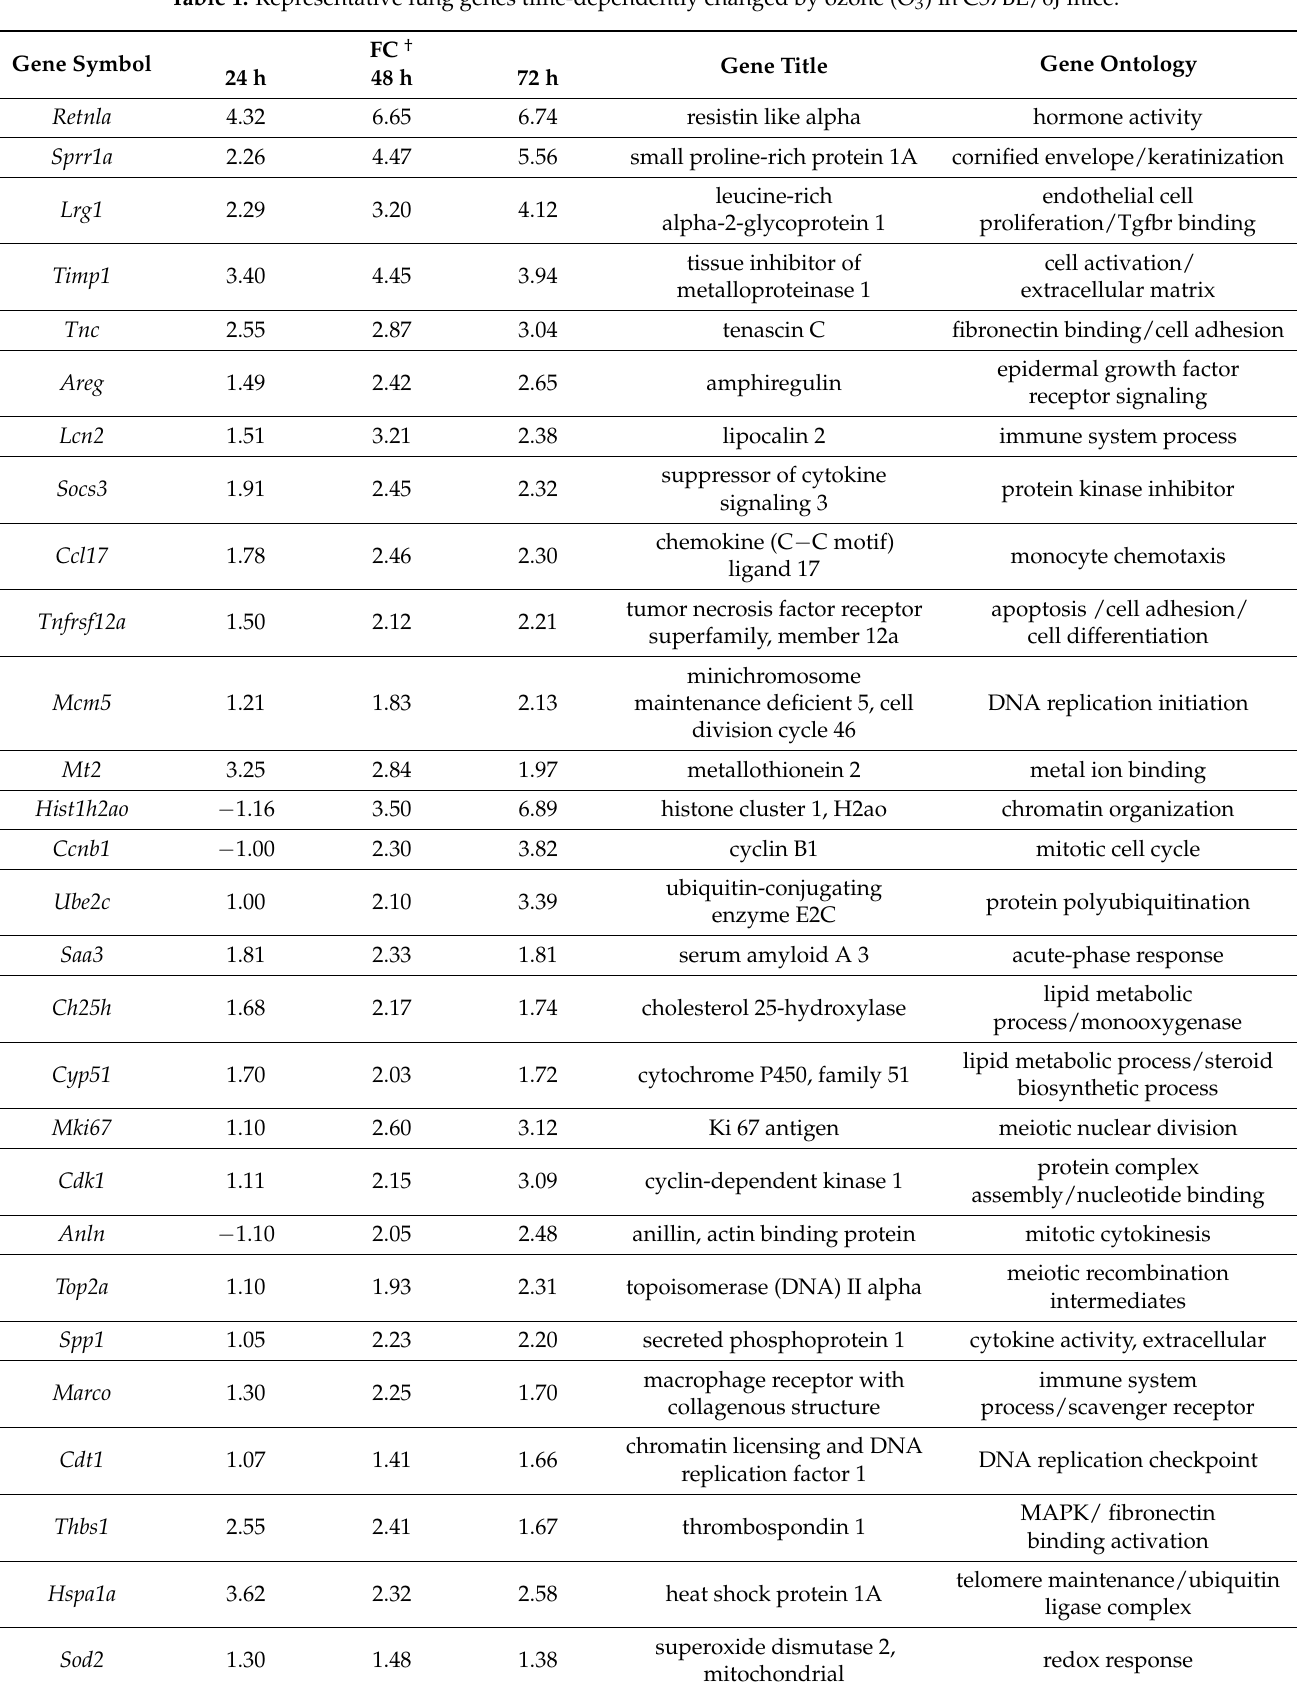
Table 1. Representative lung genes time-dependently changed by ozone (O 3 ) in C57BL/6J